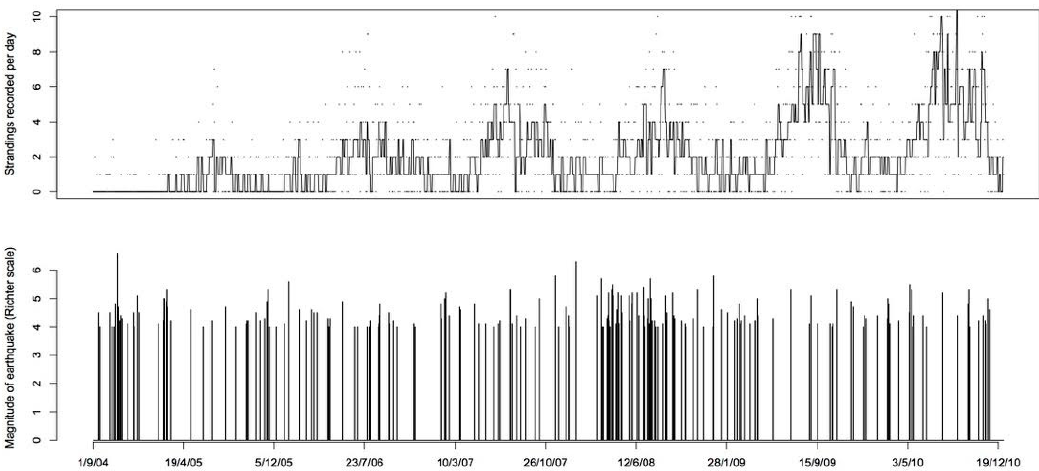
Figure 5. The top panel shows the time series of the number of standing events recorded each day, with a Tukey’s running median smoother. The bottom panel shows the earthquakes occurring on each day and their magnitude on the Richter scale.